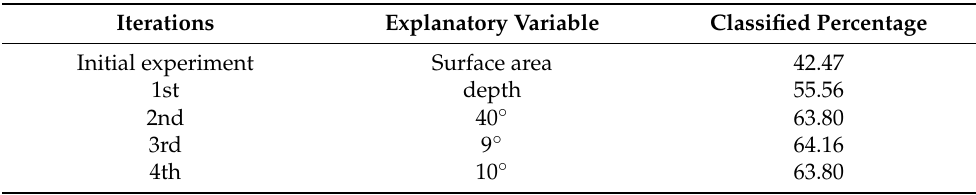
Table 6. Selected feature variables for predicting the sediment types when samples were from all four